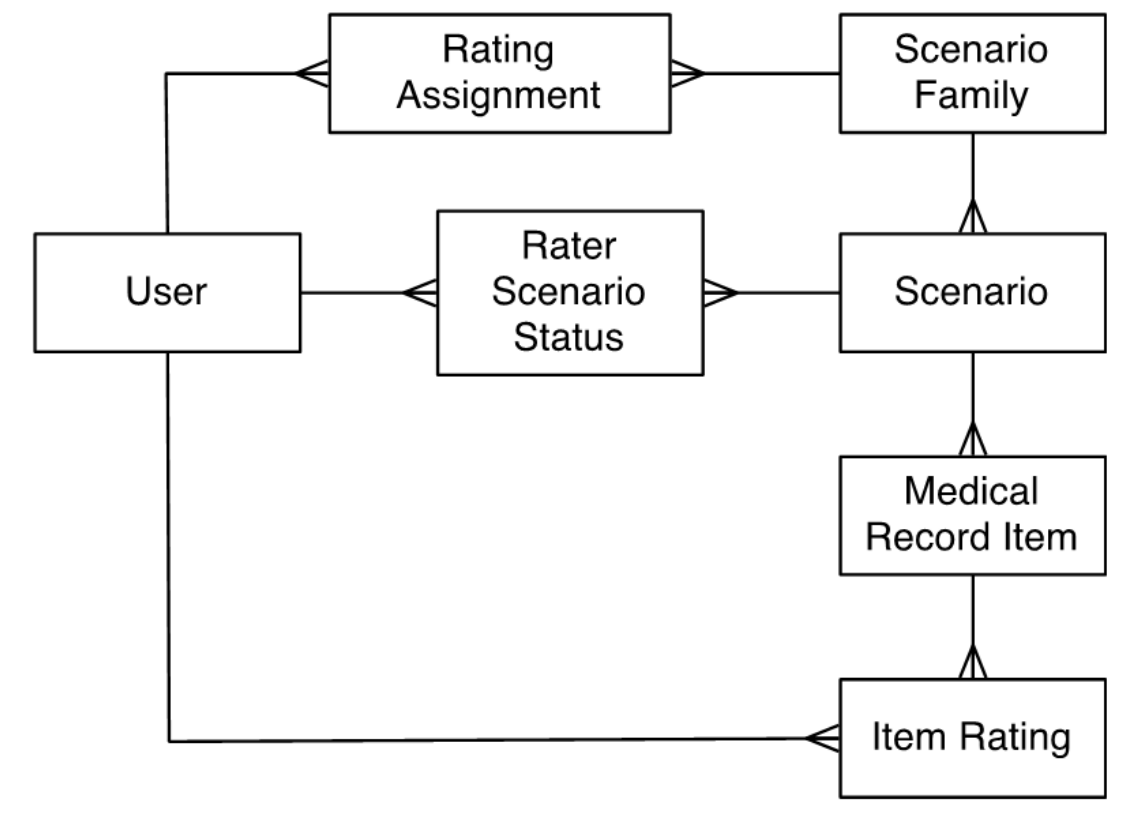
Figure 1. Rating collection tool data model. Inside the collection tool, each set of sample medical records is represented by a ScenarioFamily object, which contains many Scenario objects, which in turn contains many MedicalRecordItems. Expert raters are represented by User objects and are associated with a ScenarioFamily via a RatingAssignment. Raters create an ItemRating object for each MedicalRecordItem within Scenarios belonging to each ScenarioFamily to which they are